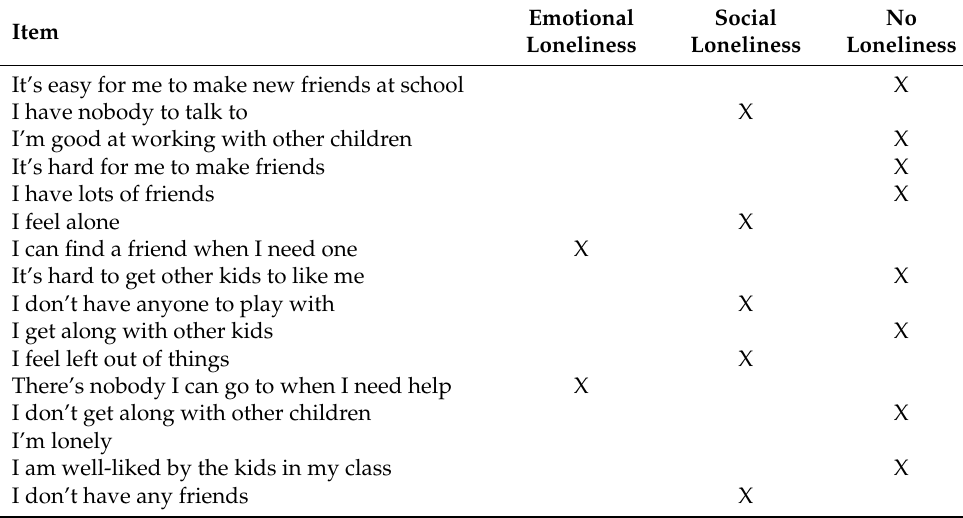
Table 2. Coding of Items of the Children’s Loneliness Scale